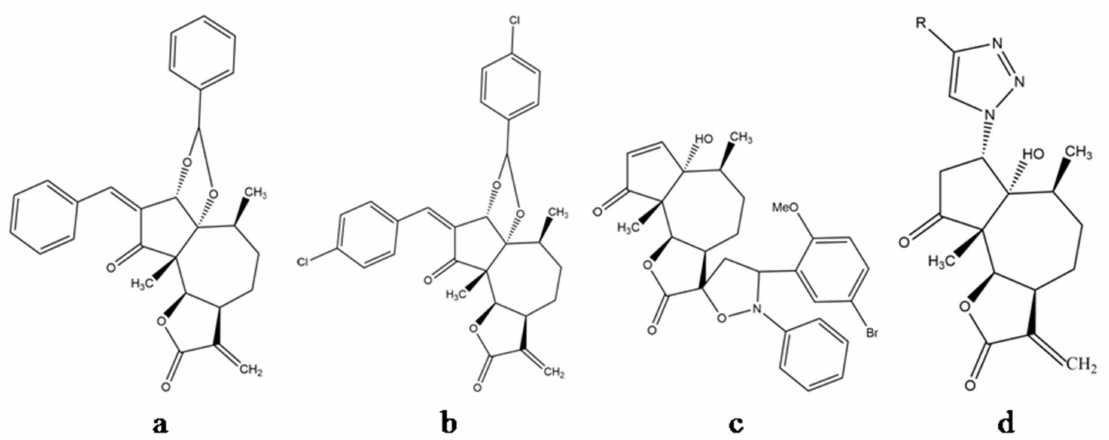
Figure 5. Compounds synthesised from parthenin: ( a ) P16, ( b ) P19, ( c ) SLPAR 13, and ( d ) 1,2,3-triazole derivatives of